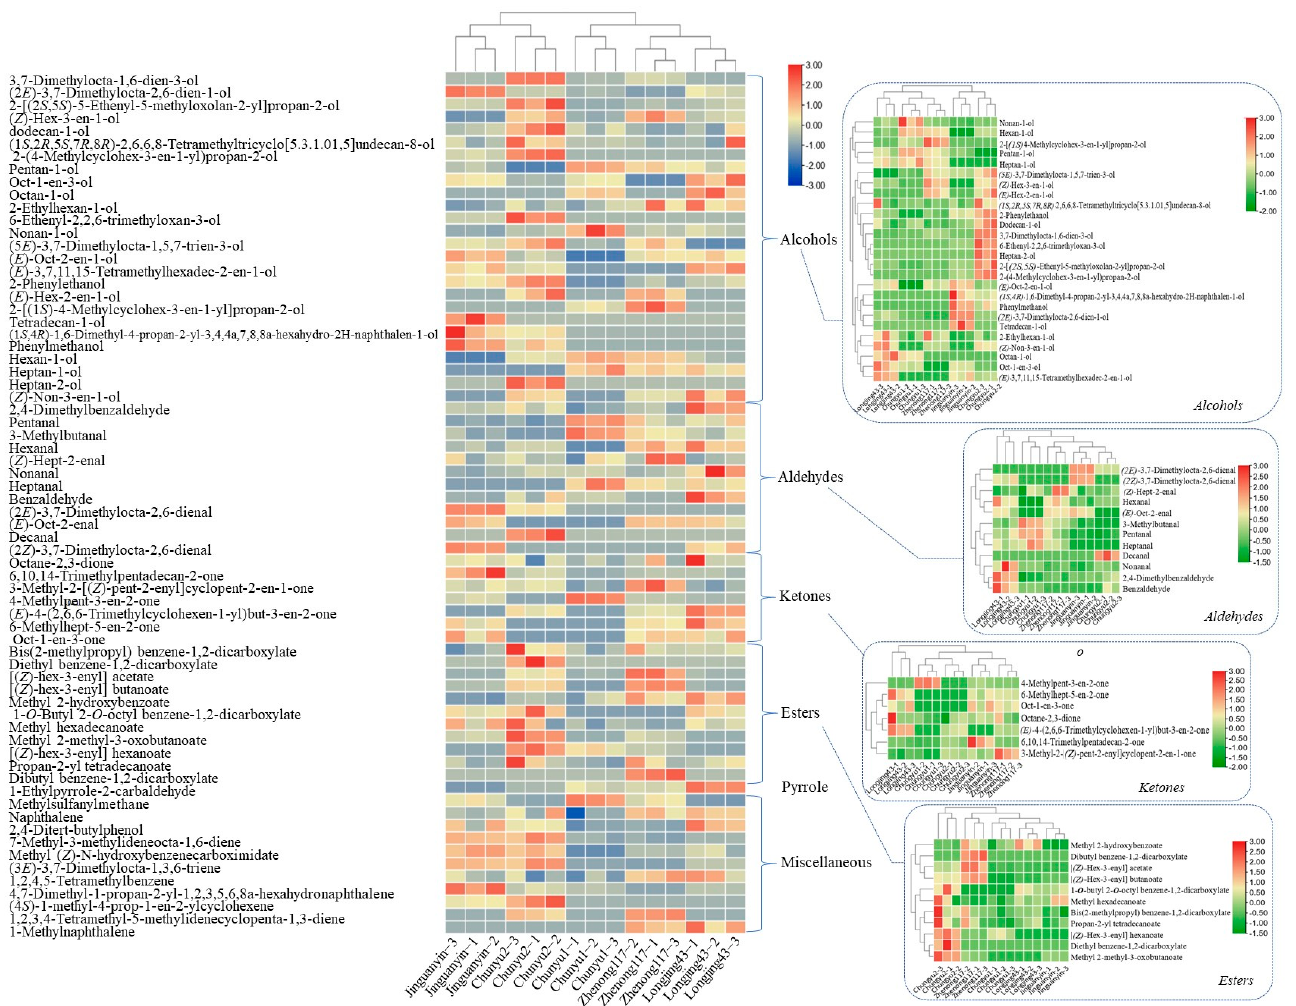
Figure 2. The hierarchical heatmap of the relative contents of volatile compounds in different green teas. Guaiacol was used as an internal standard to normalize the metabolite signal.